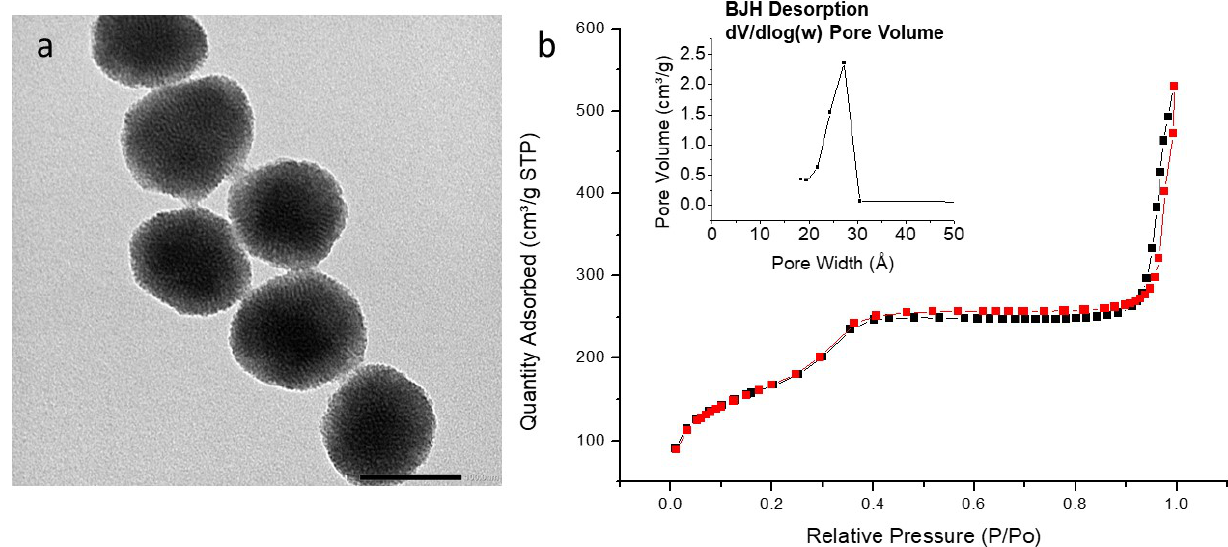
Figure 3. ( a ) TEM image of PMO 1 NPs, scale bar 100 nm. ( b ) Nitrogen adsorption–desorption at 77 K. Insert BJH desorption (dV/dlog(w)) Pore Volume.